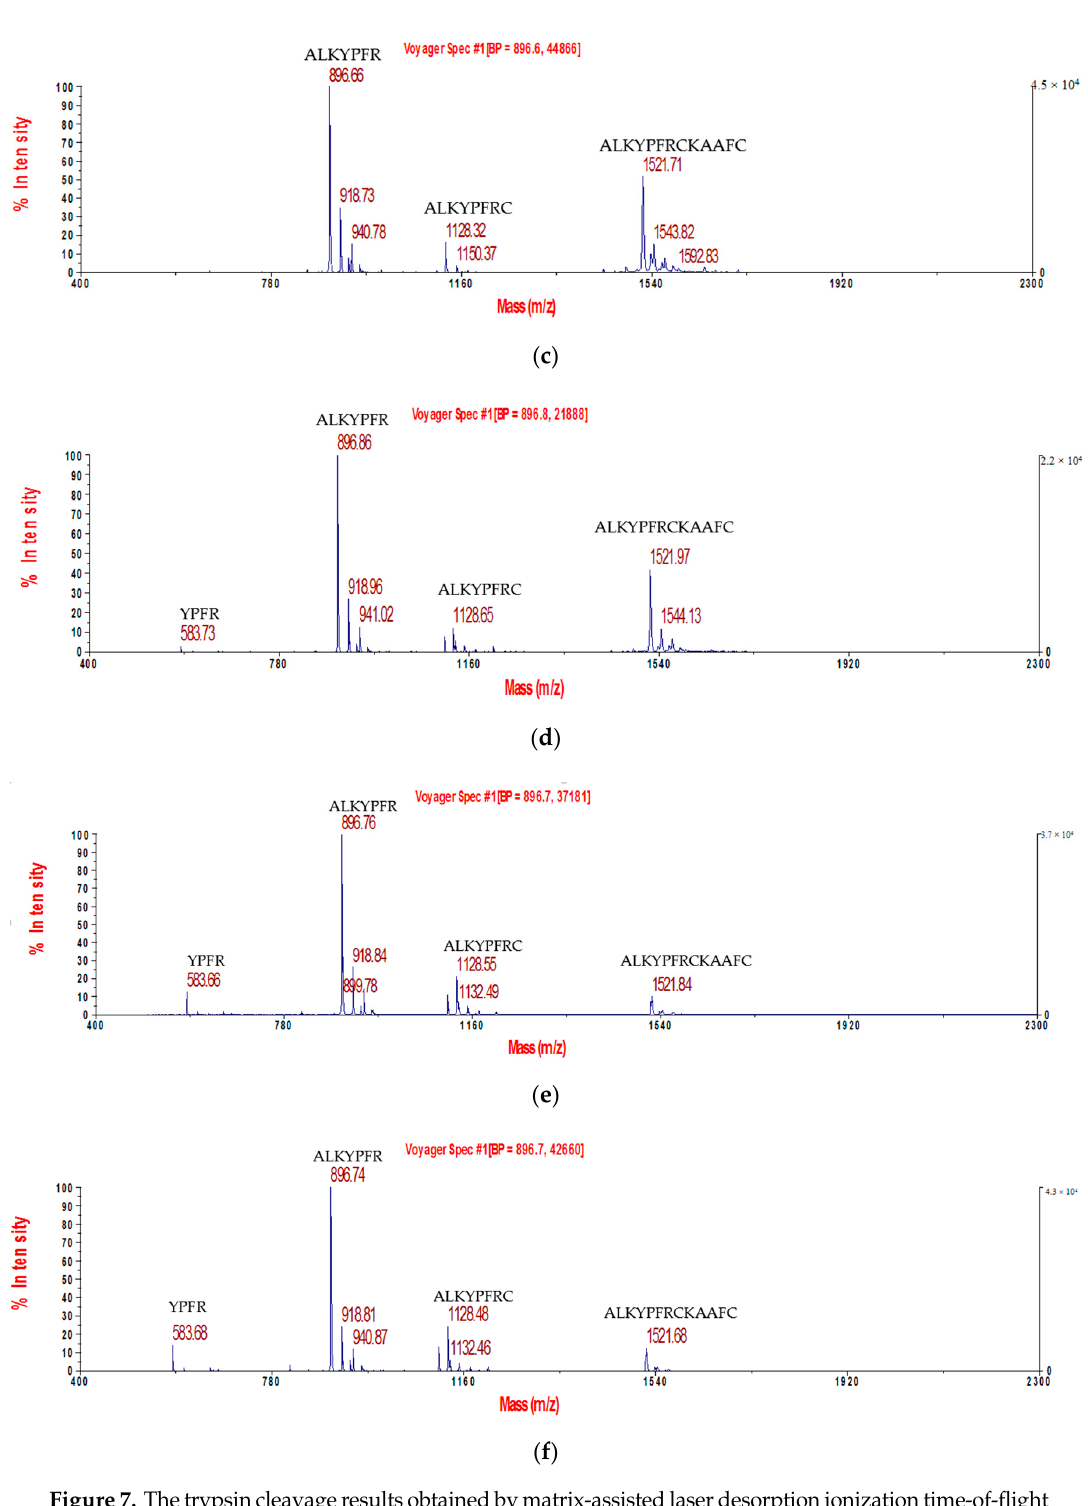
Figure 7. The trypsin cleavage results obtained by matrix-assisted laser desorption ionization time-of-flight (MALDI-TOF) analysis for Kunitzin-OV from different time points, (a) to (f): 0 min, 1 min, 2 min, 5 min, 10 min, and 20 min. The obtained fragments are marked in the figure.